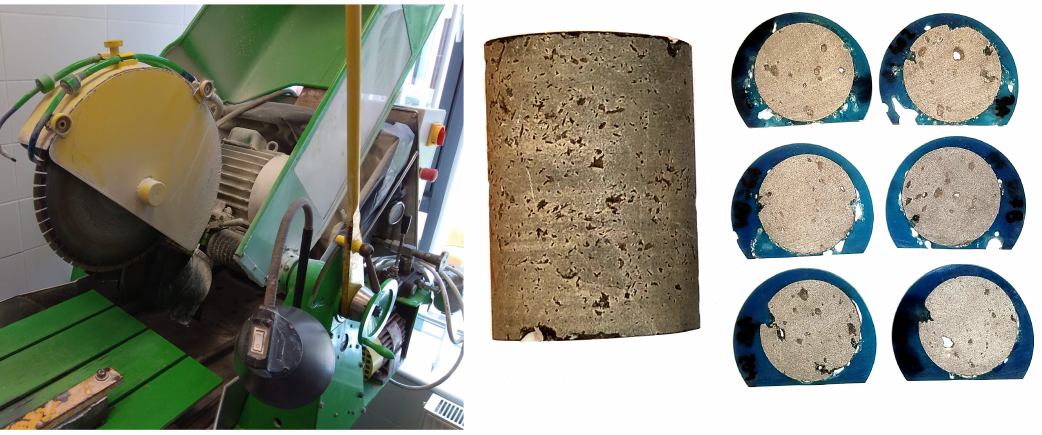
Figure 1. Rock cutting saw ( left ), core before cutting ( center ) and some examples of sliced core ( right